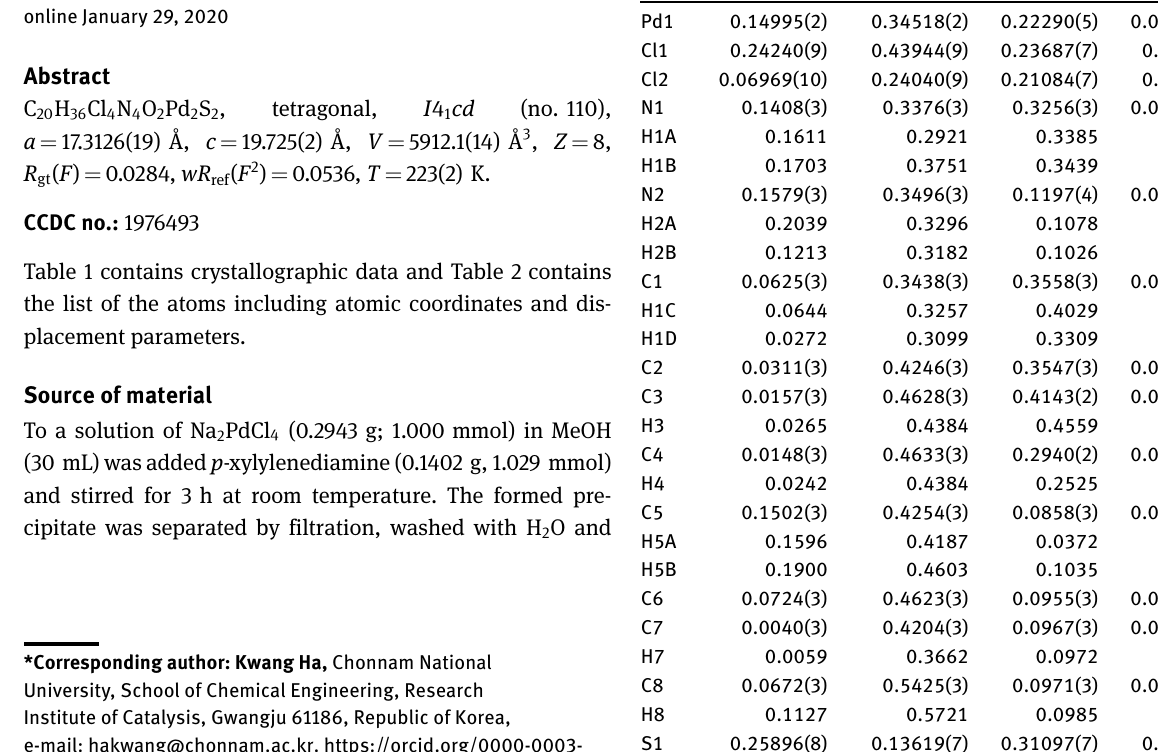
Table 1 contains crystallographic data and Table 2 contains the list of the atoms including atomic coordinates and dis- placement parameters.